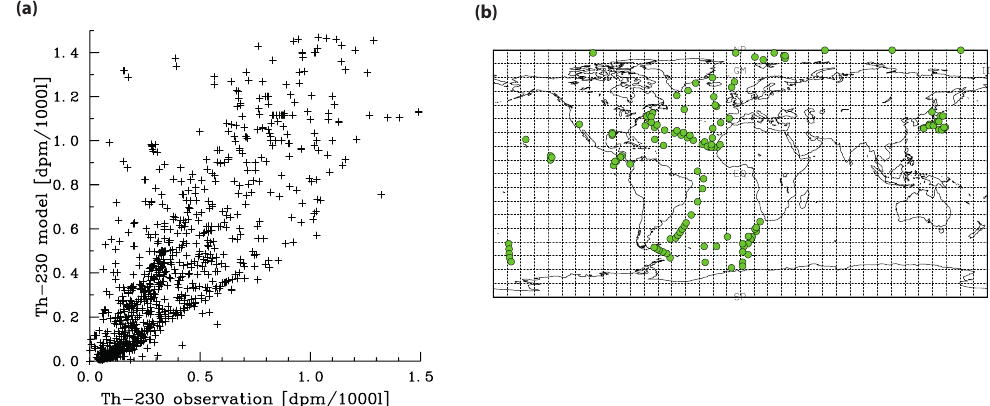
Figure 5. Comparison of dissolved 230 Th model results with observations (for references of observations, see the text). (a) Correlation between observations and modelled values. (b) Location of all vertical profiles used in this work.